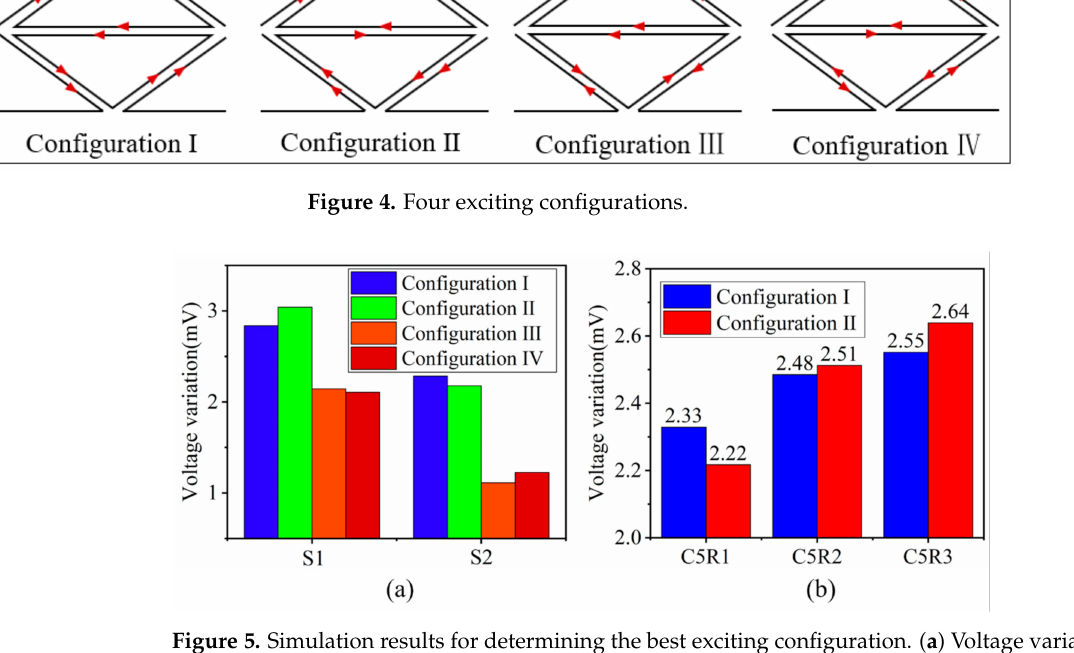
Figure 5. Simulation results for determining the best exciting configuration. ( a ) Voltage variations of the S1 and S2 when the crack is set at C5R1. ( b ) Voltage variations of S2 when the crack propagates in the radial direction at C5.